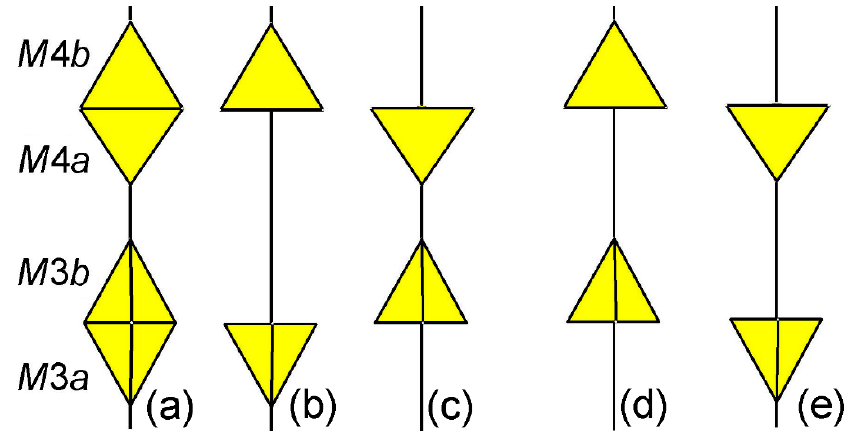
Figure 6. ( a – e ) A scheme showing different options of mutual orientation of the M 3 and M 4 tetrahedra.